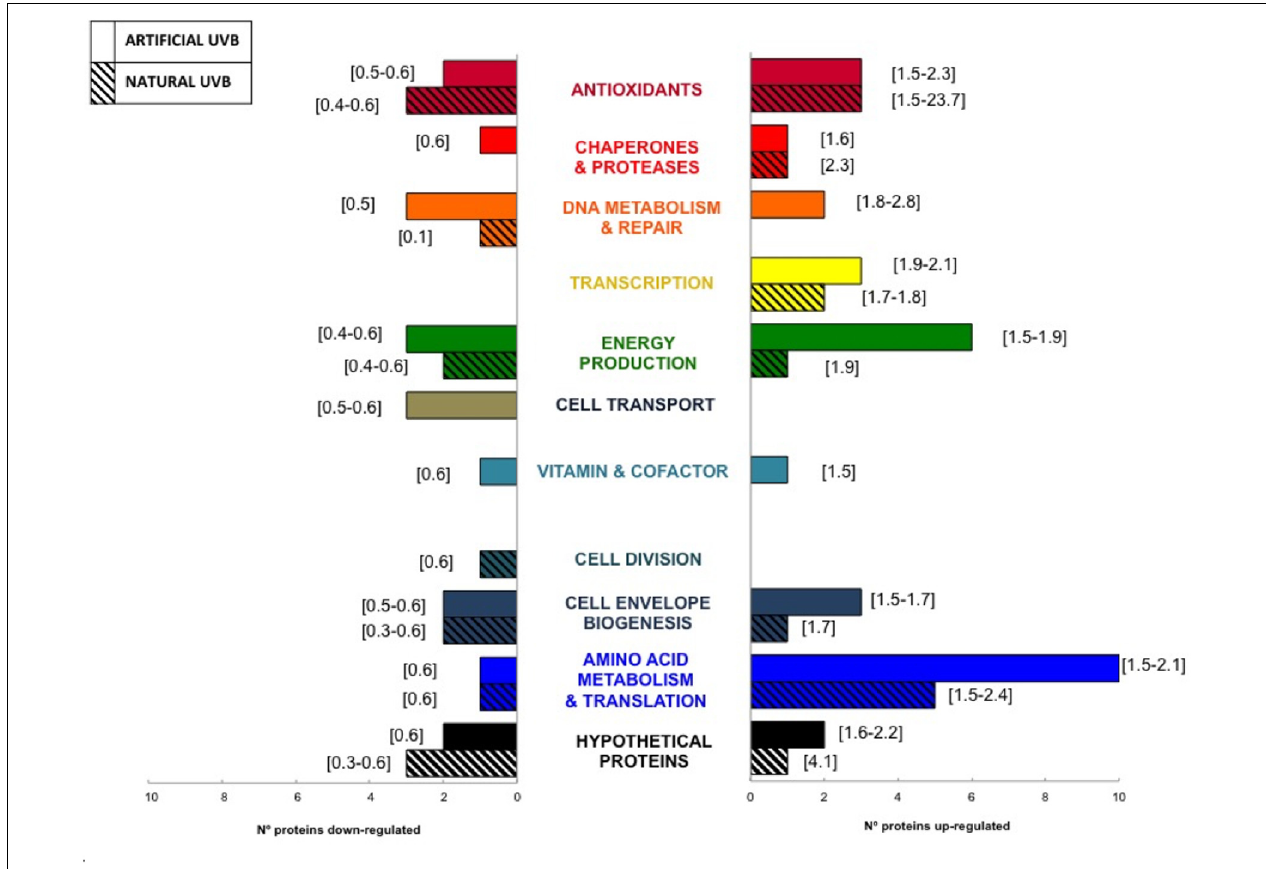
FIGURE 4 | Comparison of the number of up-regulated (rightside histogram) and down-regulated (leftside histogram) proteins for both Natural and Artificial UVB conditions. Numbers into brackets represent the range of proteomics ratios for each functional category.